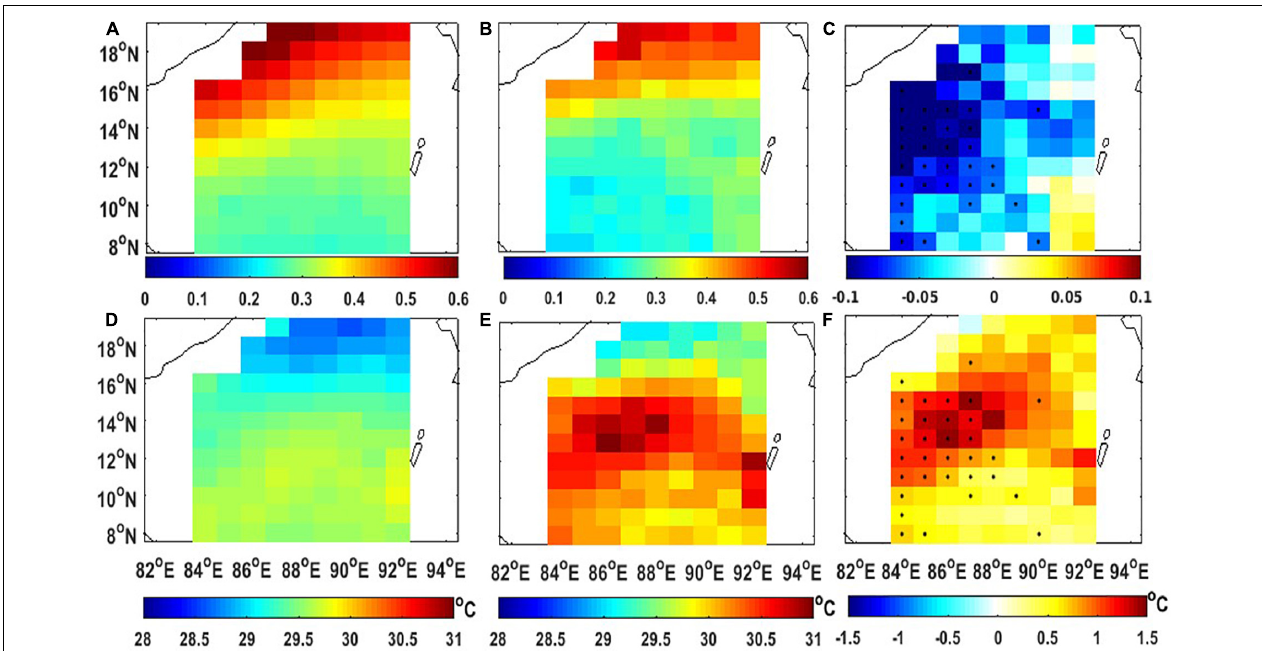
FIGURE 2 | (A) Climatological aerosol loading during April 2003–2019. (B) Aerosol loading during April 2020. (C) AOD anomaly (dots signify regions where AOD change is more than 20%). (D) Climatological SST during April 2003–2019. (E) SST during April 2020. (F) SST anomaly (dots signify regions where AOD change is more than